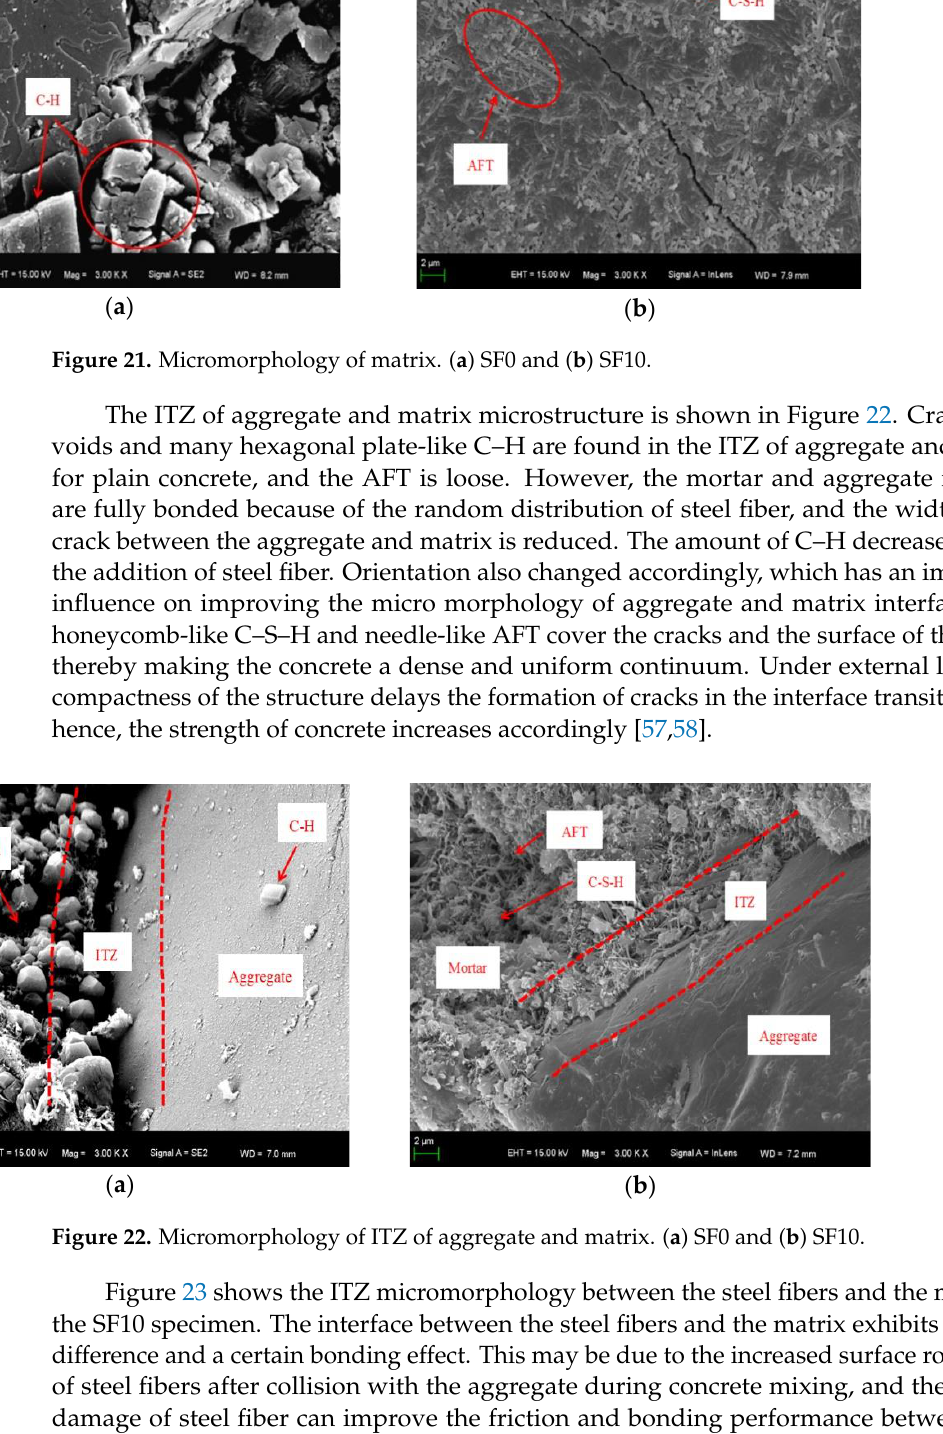
( d ) Figure 20. SEM images of specimen under a different number of F – T cycles: ( a ) SF0 with 0 F – T cycles, ( b ) SF0 with 200 F – T cycles, ( c ) SF10 with 0 F – T cycles and ( d ) SF10 with 200 F – T cycles. Figure 21 shows the microstructure of the SFRC matrix. It can be seen that a greater number of calcium hydroxide (C – H) exists in plain concrete matrix, and the amounts of hydrated calcium silicate (C – S – H) and Ettringite (AFT) are relatively small. Many micro